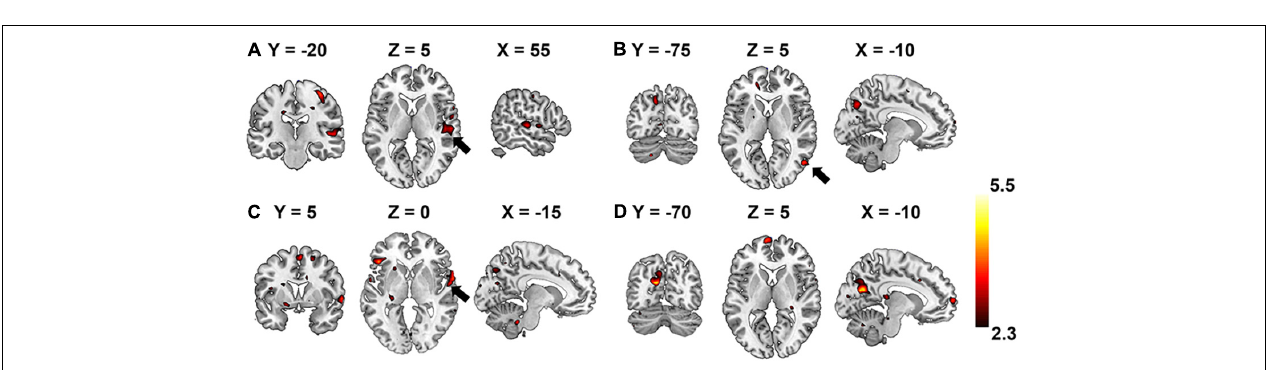
FIGURE 9 | Brain regions that are selectively activated by the hierarchical acoustic features represented in each layer of the supervised classification model. Panels (A–D) represent the first four layers in the supervised classification